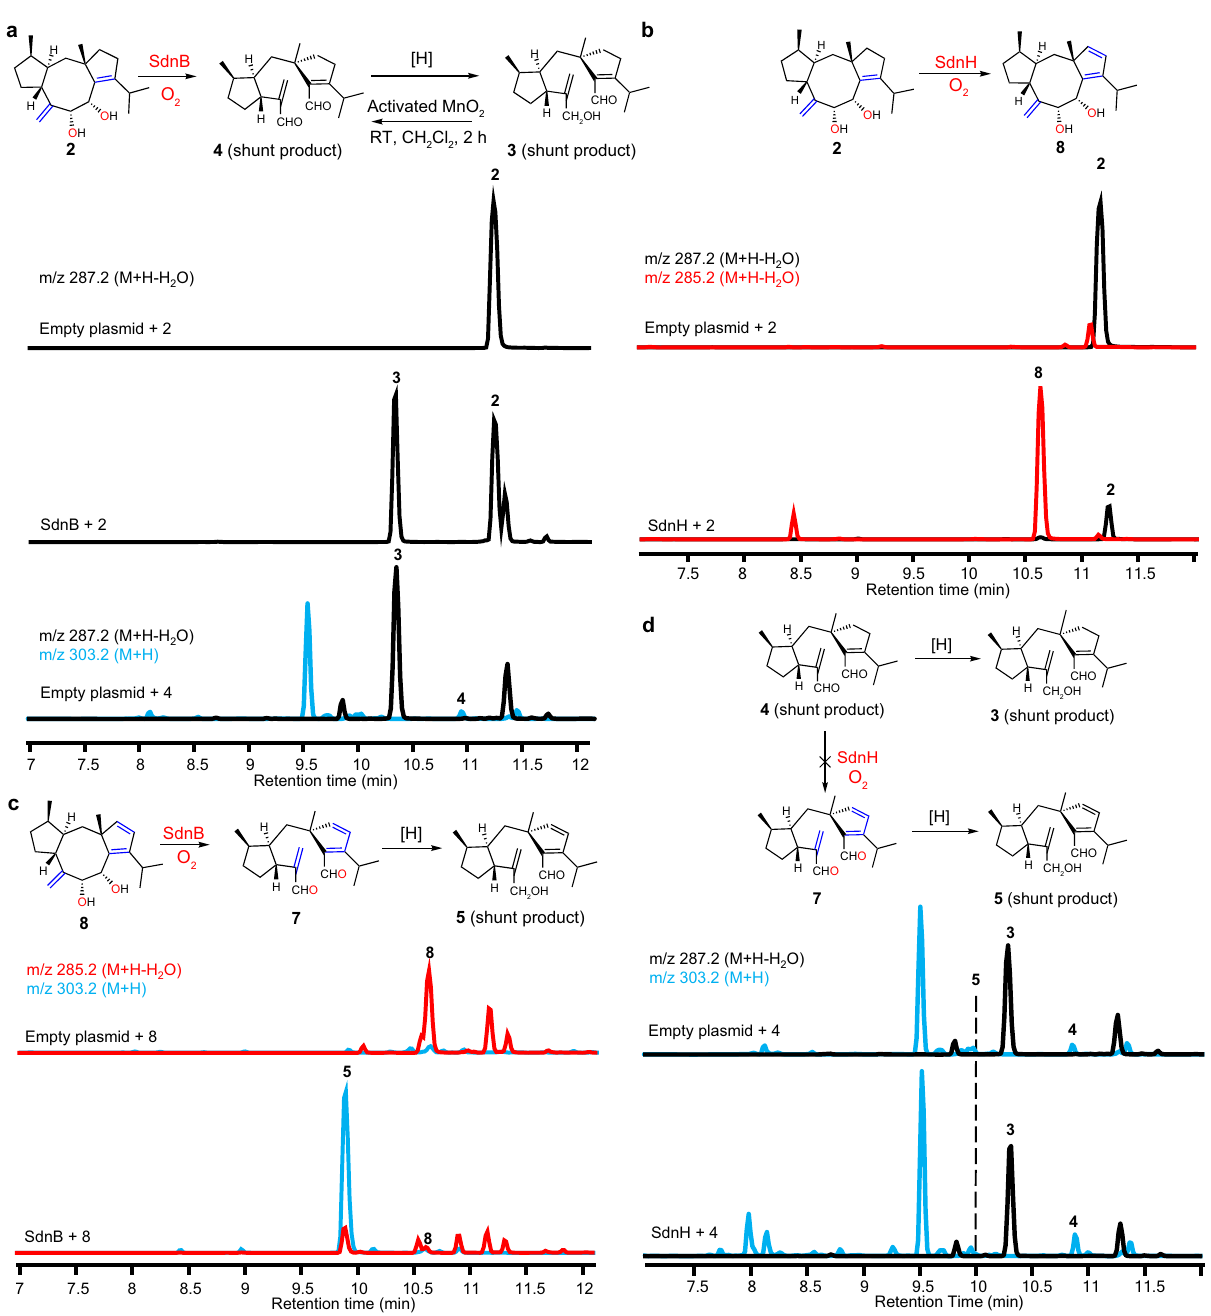
Fig. 3 Biotransformation probing the function of SdnB and SdnH. a Biotransformation of 2 by A.nidulans expressing SdnB. b Biotransformation of 2 by A.nidulans expressing SdnH. c Biotransformation of 8 by A.nidulans expressing SdnB. d Biotransformation of 4 by A.nidulans expressing SdnH. Compound 4 cannot be desaturated by SdnH to form 7 (and then to 5 ) but instead was reduced to 3 by endogenous reductases in A. nidulans . The chromatograms in all cases are extracted from mass spectra of the base peak for each compound.